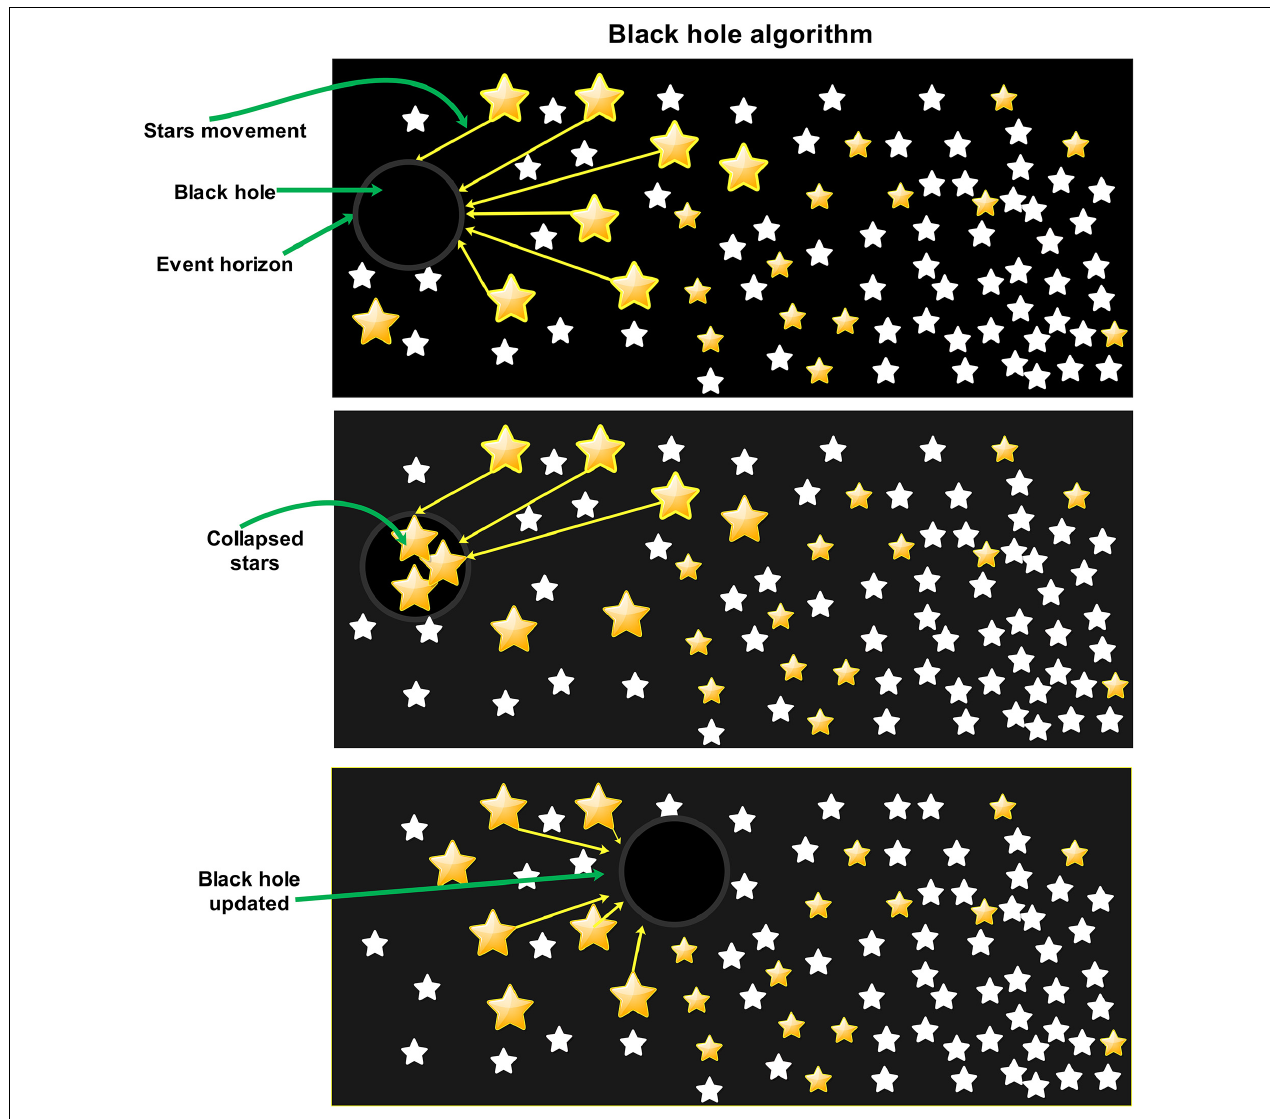
FIGURE 1 | Physical life cycle of the black hole